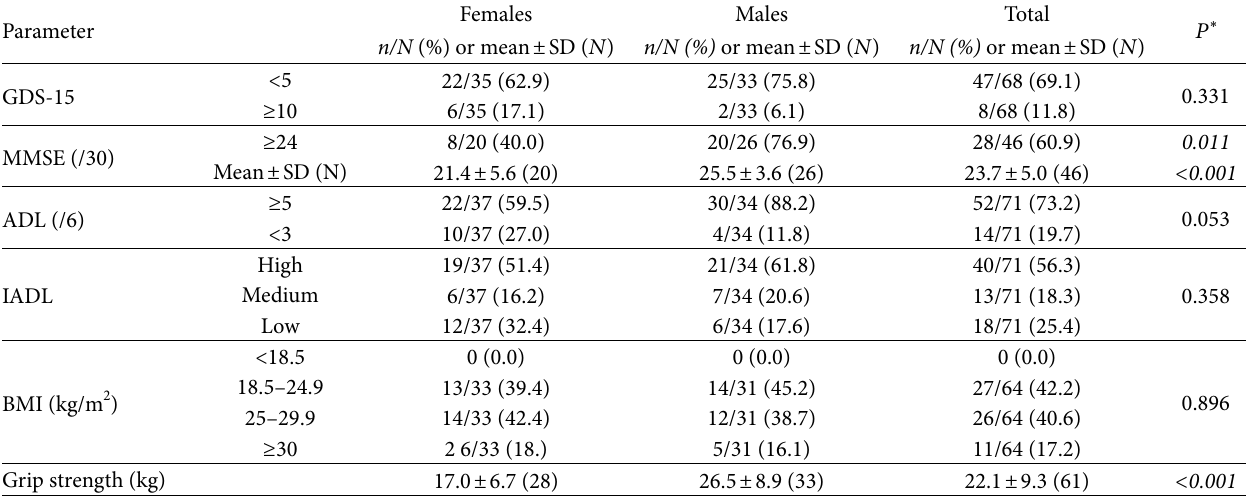
Table 4: Standardized geriatric assessment of